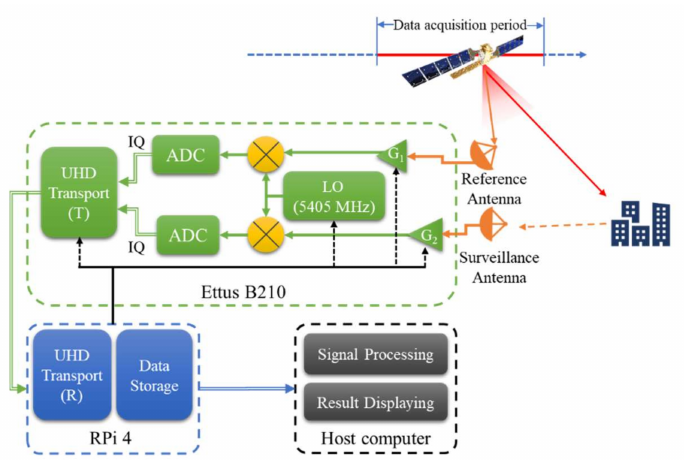
Figure 4. The general structure of the developed MF-PB-SAR system, including one SDR receiver (Ettus B210), a host computer, a RPi 4, and two antennas (reference and surveillance